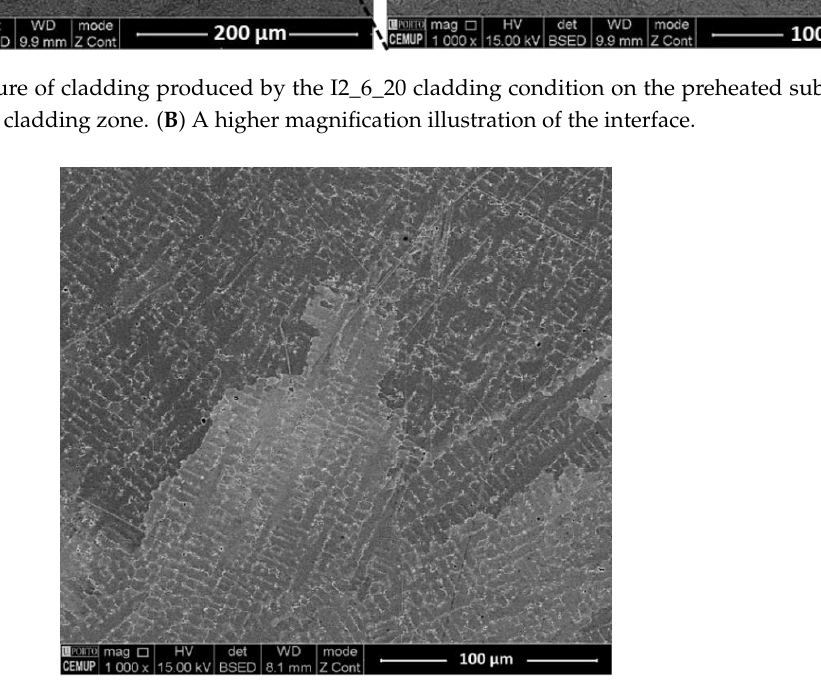
Figure 7. SEM image of the I2_6_20 cladding microstructure.